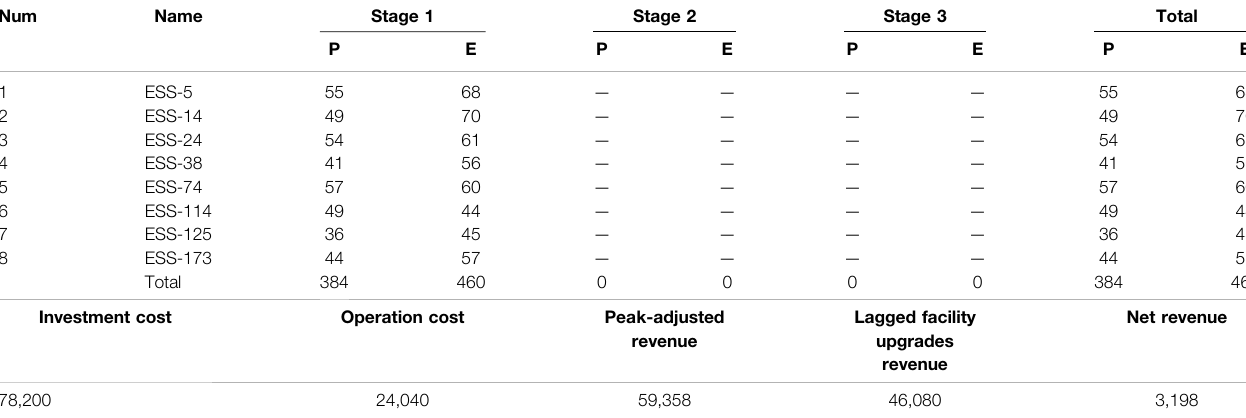
TABLE 3 | Energy storage system planning results of each stage of case III.